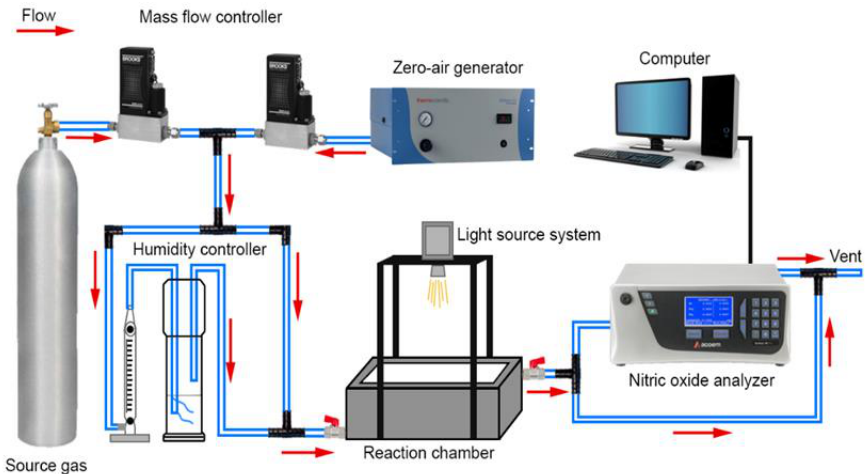
Figure 1. Illustration of the experimental layout in this study.